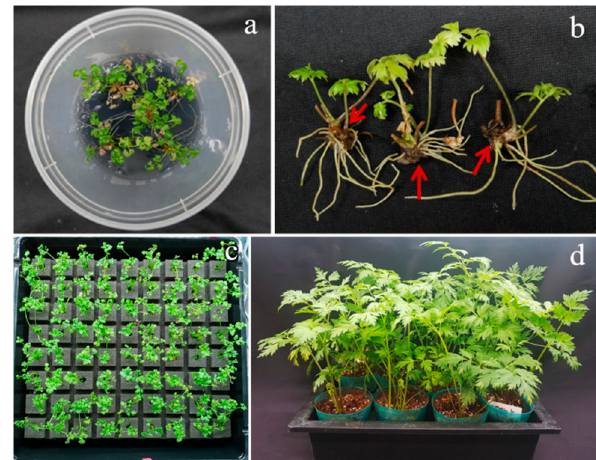
Figure 7. Rhizomes of Cnidium officinale developed with the in vitro-grown plantlets ( a , b ); ( c ) four- week-old plants growing with Growfoam; and ( d ) six-month-old plants growing in pots containing vermiculite.